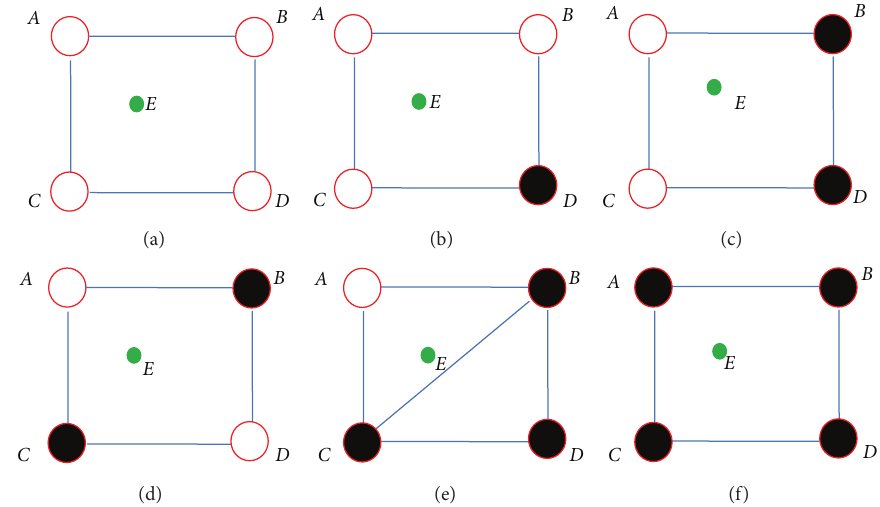
Figure 3: Classification of the five different locations: the green point 𝐸 is the pixel to be interpolated. Letters 𝐴 , 𝐵 , 𝐶 , and 𝐷 represented by red circles are four pixels around 𝐸 . (a) Four white pixels around; (b) three white pixels around; (c) and (d) two white pixels and two black ones around; (e) one white pixel and three black ones around; (f) four black pixels around.